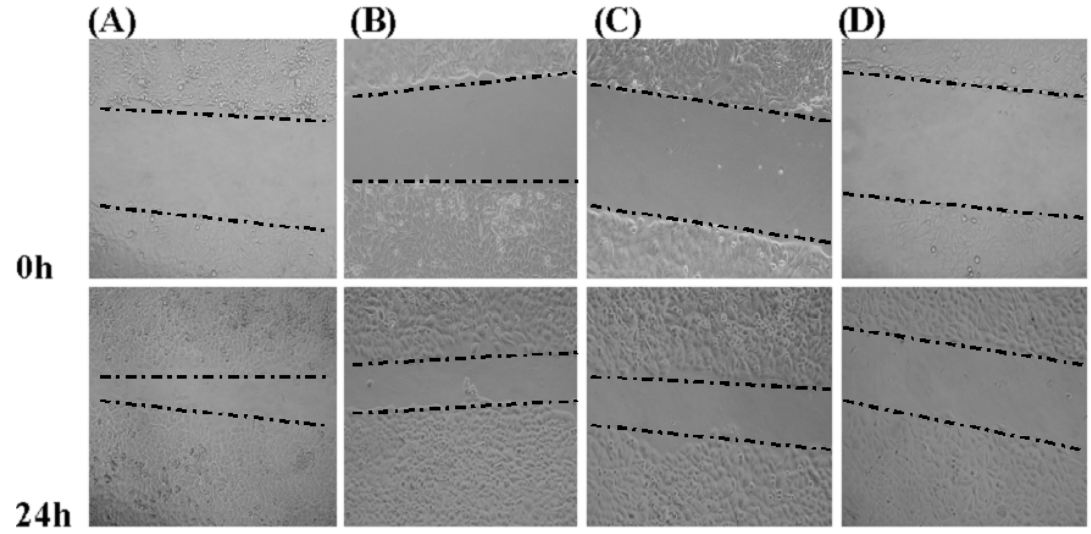
Figure 4. Wound-healing assay of Gekko sulfated glycopeptides on SMMC-7721 cells. Phase-contrast microscope was used to observe the linear wound of the cells (100×). Indicated times (0, 24 h) depict the duration after scratching of the monolayer. ( A ) Control group; ( B ) 10 µg/mL Gekko sulfated glycopeptides; ( C ) 100 µg/mL Gekko sulfated glycopeptides and ( D ) 200 µg/mL Gekko sulfated